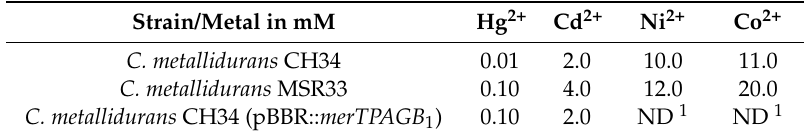
Table 1. Minimal inhibitory concentration (MIC) of heavy metals for Cupriavidus metallidurans strains MSR33 and